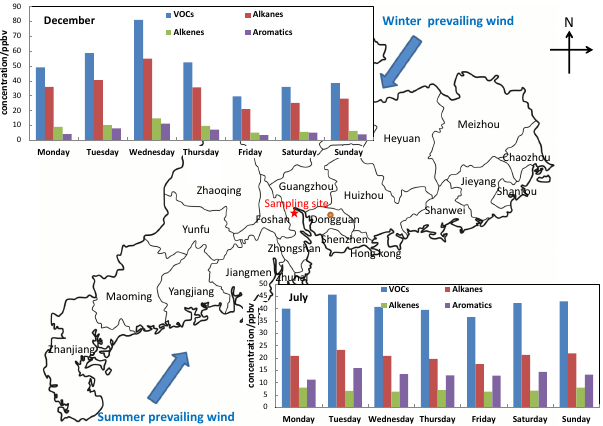
Figure 1. The location of observation site at GPACS and its sur- rounding area. The red pentagram represents the sampling site, and the golden circle represents Dongguan City. The VOC profiles for July when the summer prevailing wind is SW and for December when the winter prevailing wind is NE are shown in the bar